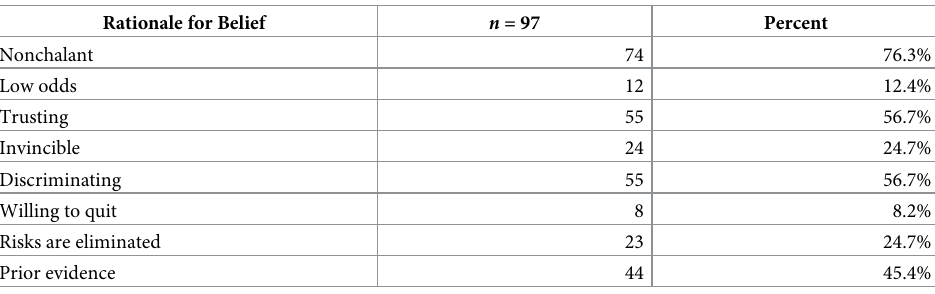
Table 5. “Safe from harm”